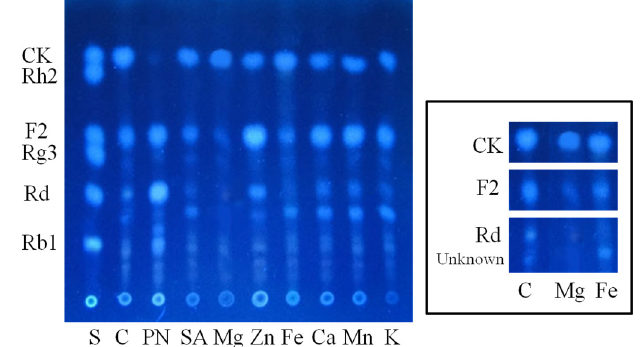
Figure 5. Influences of different elicitors on the biotransformation of Rb1. C: control; PN: PNPG; SA: sodium salicylate; Mg: MgSO 4 ; Zn: ZnSO 4 ; Fe: FeSO 4 ; Ca: CaCl 2 ; Mn: MnSO 4 ; K: KH 2 PO 4 .